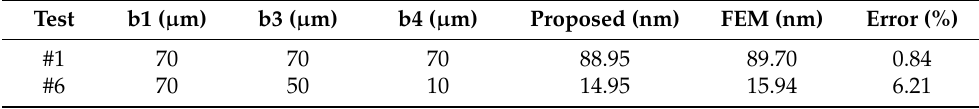
Table 6. Tip displacement when the second layer is